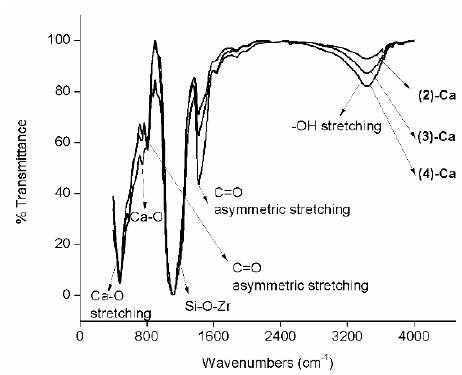
Figure 7. Fourier transform infrared (FTIR) spectra for samples calcined at 700 ◦ C: ( a ) SiO 2 spheres (dot point), SiO 2 @ZrO 2 0.04 M (1), SiO 2 @ZrO 2 0.06 M (2), SiO 2 @ZrO 2 0.08 M (3), ( b ) zoom FTIR spectra between 400 and 950cm − 1 .